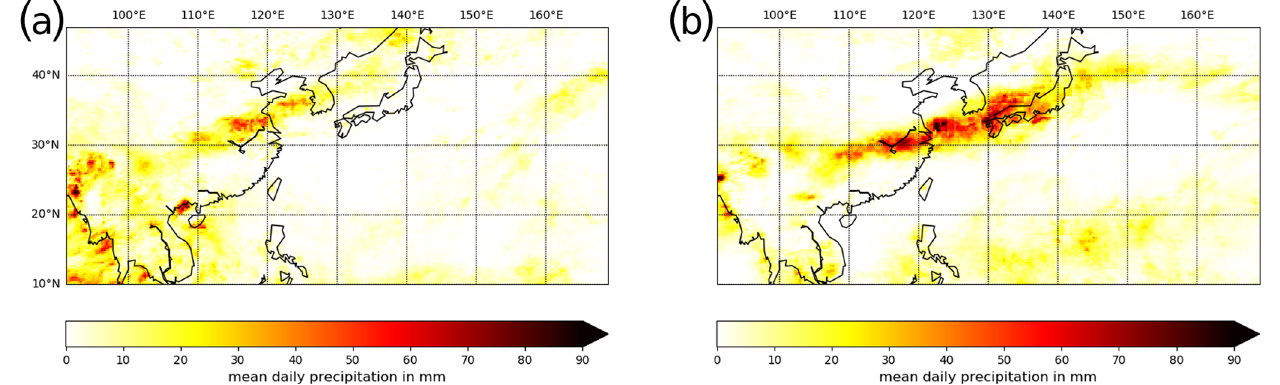
Figure 8. Mean daily precipitation (a) between 29 June and 3 July 1998 and (b) between 25 and 30 June